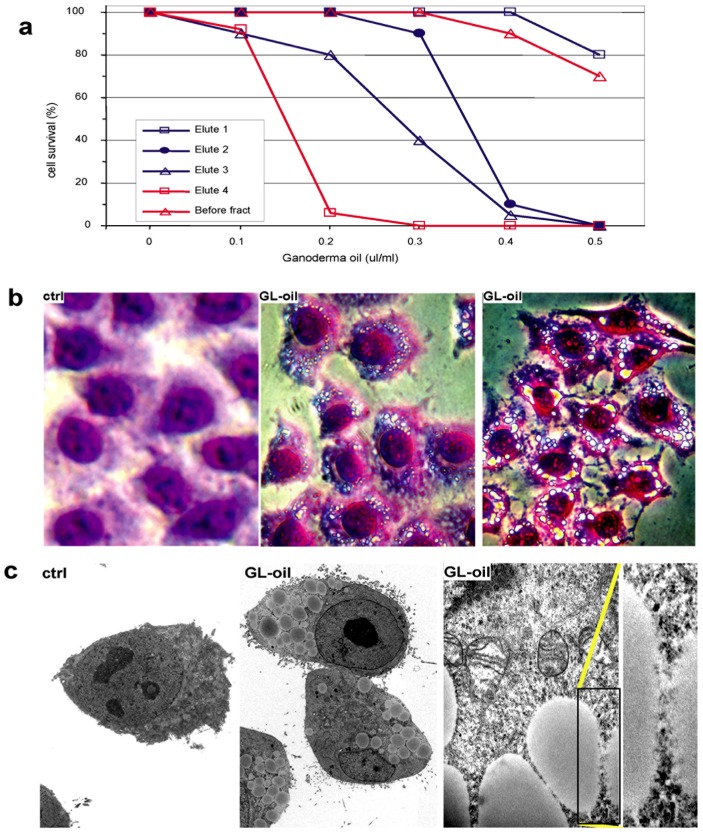
The effects of biologically active components on tumor cell death.(a) Biologically active fractions were eluted with different chemicals, followed by analysis of their effects on tumor cell death. The fraction eluted by methanol (Elute 4) produced the greatest activity, while Elute 1 and the sample before fractionation (Before fract) displayed the lowest activity on inducing tumor cell death. (b) The MT-1 cells treated with or without Ganoderma oil were fixed, and stained with the Diff-Quik-Stain kit, followed by microscopic examination. A great number of vacuoles were detected in the cells treated with Ganoderma oil. (c) The Ganoderma oil treated cells were subjected to electronic microscopic examination. Large vacuoles could be seen clearly.